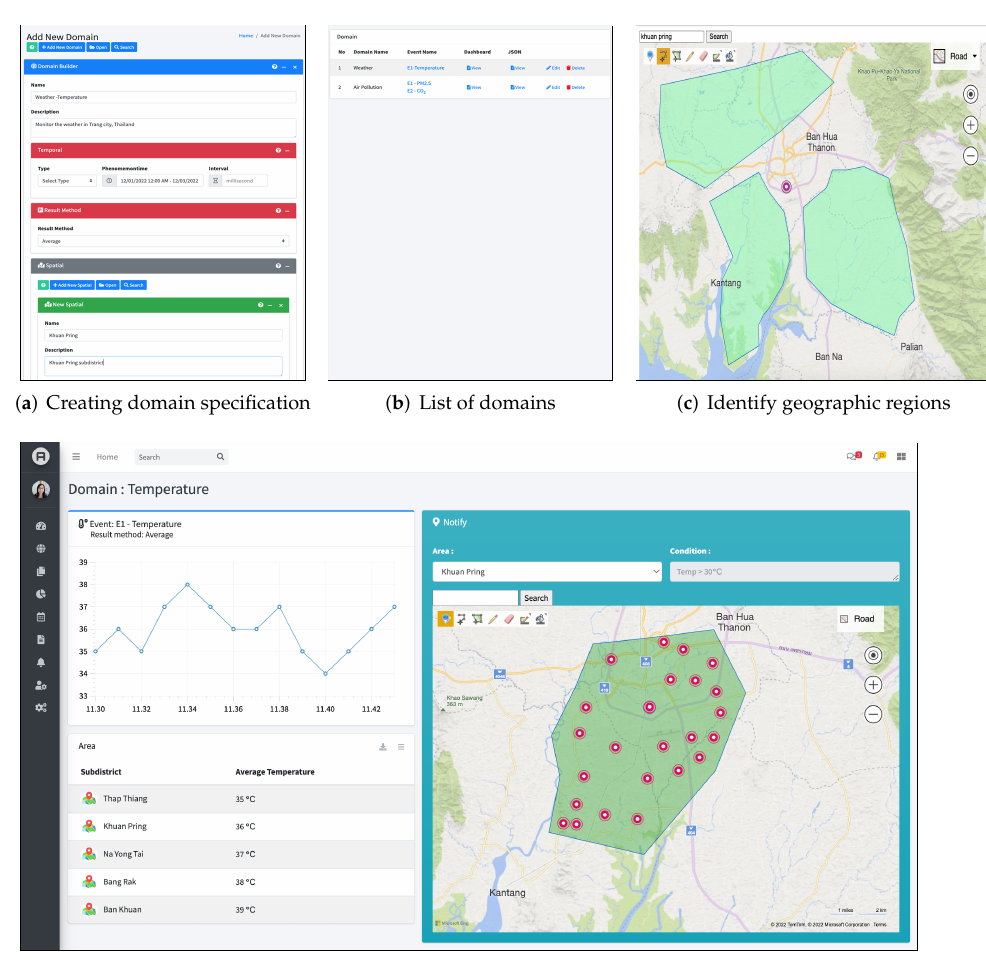
Figure 5. Screenshots of a web interface of the SEMi application for graphical querying and visualized context